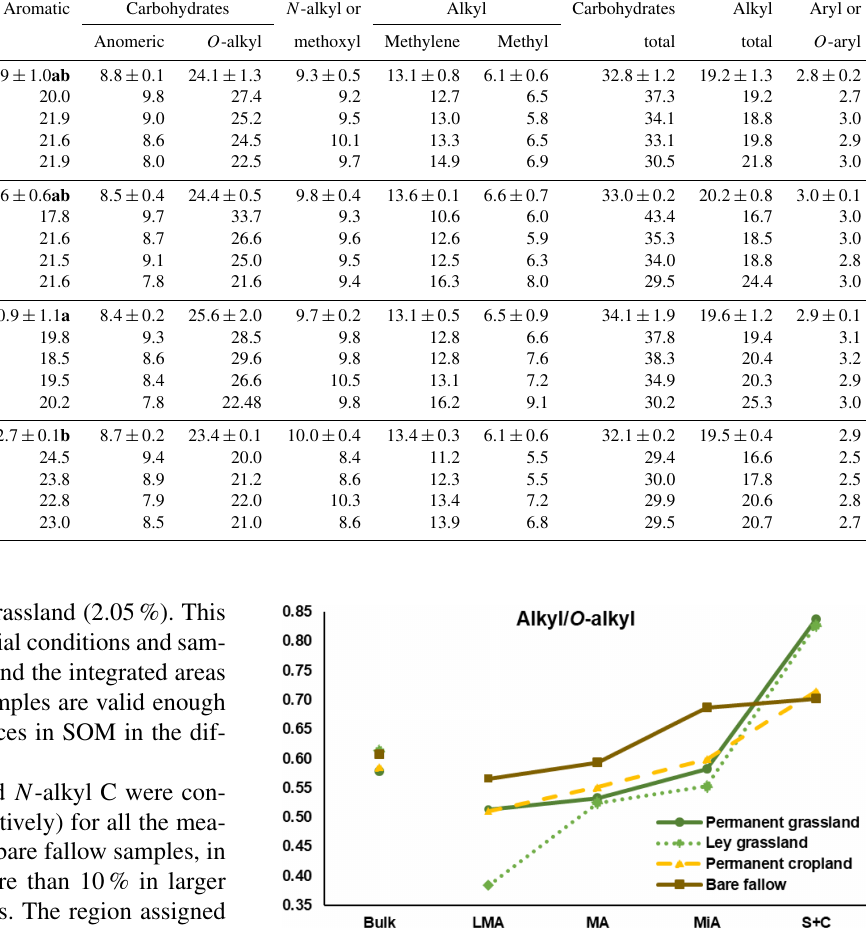
Figure 5. The alkyl to O -alkyl ratios calculated for light fraction C isolated from bulk soils and aggregate fractions for the four treat- ments. Note: LMA – larger macroaggregate; MA – macroaggregate; MiA – microaggregate; and S + C – silt and